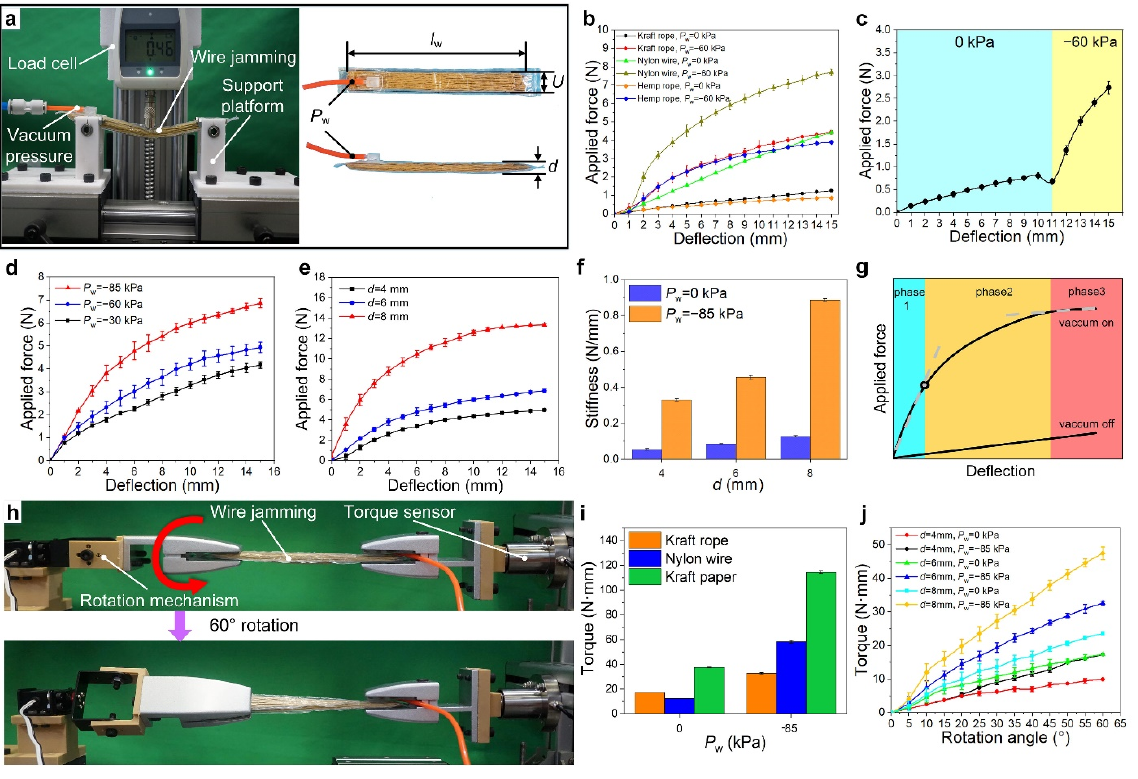
Figure 4. Characterization of bending and torsional stiffness of wire jamming structures. ( a ) Experimental setup for three-point bending stiffness tests and detail display of wire jamming structure using kraft rope, where l w is the length of wires (range from 140 to150 mm), U is the width, P w is the vacuum pressure, and d is the thickness of jamming structures. ( b ) Applied force versus deflection curves of wire jamming structures ( d = 6 mm) using three different jamming media (i.e., kraft rope, nylon wire and hemp rope) at 0 kPa and − 60 kPa vacuum pressure. ( c ) Applied force versus deflection curve with a vacuum pressure change at a deflection of 11 mm. ( d ) Influence of different confined vacuum pressures on the bending stiffness. The thickness d is 6 mm. ( e ) Influence of different confined thicknesses on the bending stiffness. The vacuum pressure is − 85 kPa. ( f ) Comparison of bending stiffness with different thicknesses at a deflection of 15 mm. ( g ) A typical mechanical behavior curve of wire jamming structures. ( h ) Experimental setup for torsional stiffness. ( i ) Comparison of the torsional stiffness at a rotation angle of 60°. The thickness of all jamming structures is 6 mm. ( j ) Torque versus rotation angle curves under different thicknesses, where kraft rope is used as jamming material.